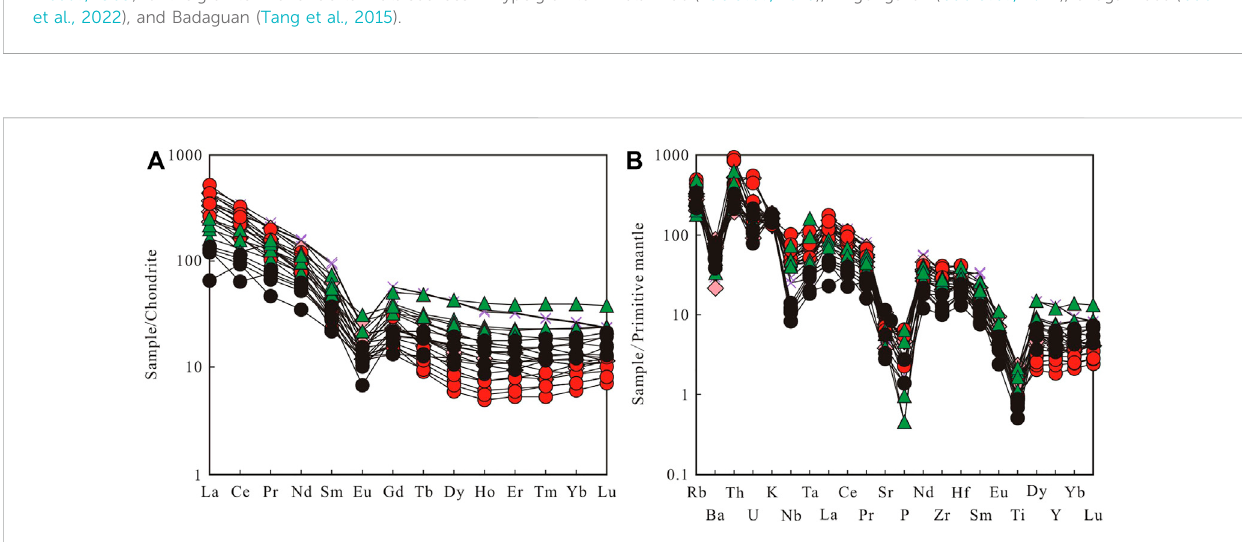
FIGURE 5 (A) Chondrite-normalized REE diagram and (B) primitive-mantle-normalized trace element diagram for the granite in Chuhuertu. The normalizing values are from Sun and McDonough (1989). Symbols are the same as in Figure